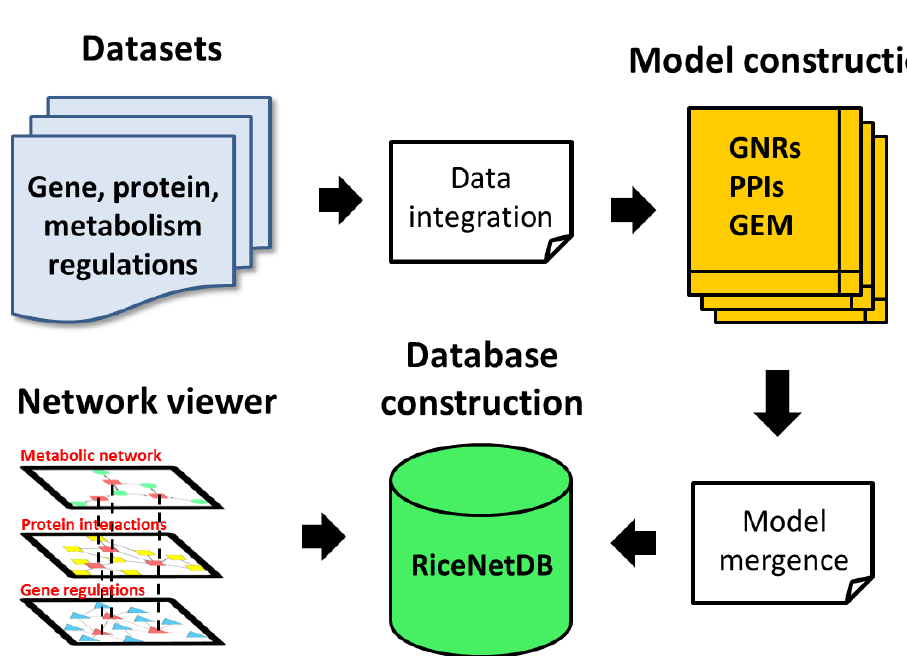
Figure 1: A workflow of genome-scale multi-level network reconstruction of